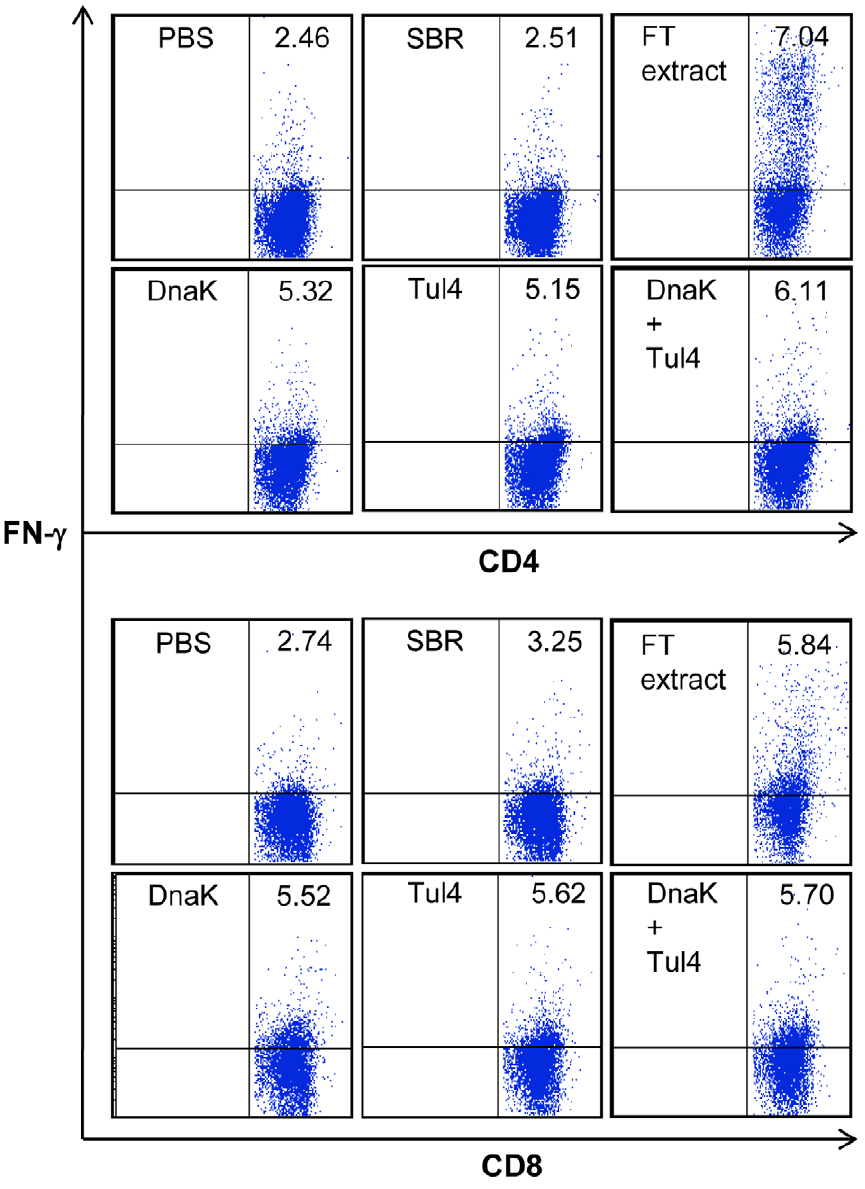
Figure 1. DnaK and Tul4 are recognized by CD4 + and CD8 + T cells during respiratory FT LVS infection. Spleen cells from FT LVS infected mice were cultured for 18–24 h with DnaK, Tul4, DnaK + Tul4 or with FT LVS extract (FT extract), which served as a positive control. Negative control wells were cultured with an irrelevant protein, SBR, or media alone. Protein transport inhibitor, brefeldin A, was added to cultures during the last 4 h of incubation, and then cells were stained with fluorochrome-labeled antibodies followed by FACS analysis. Representative FACS dot plots for intracellular IFN- c positive CD4 + and CD8 + T cells are shown.